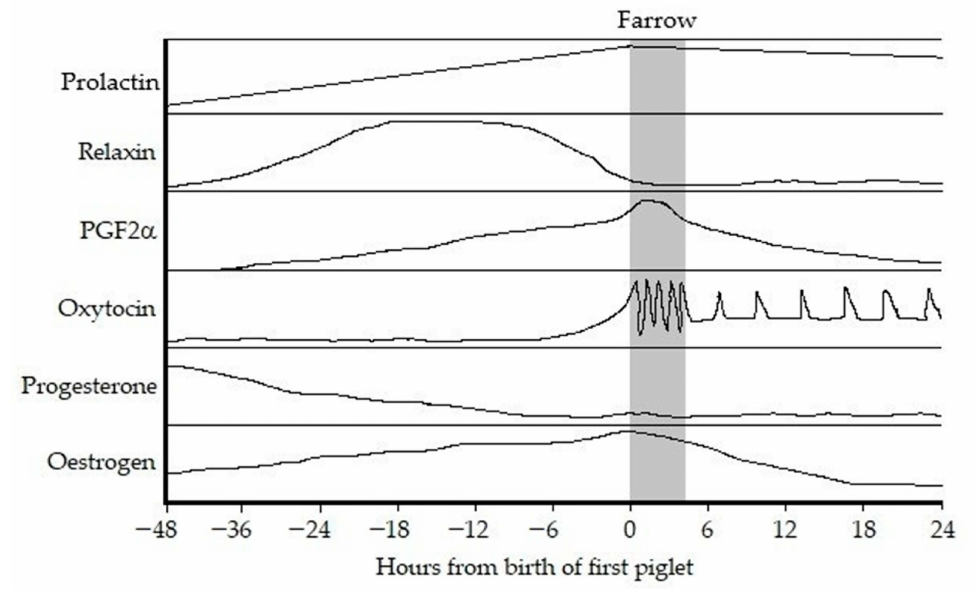
Figure 1. Patterns of periparturient plasma hormone concentrations in the pig. Unscaled. Adapted from [35] and used with